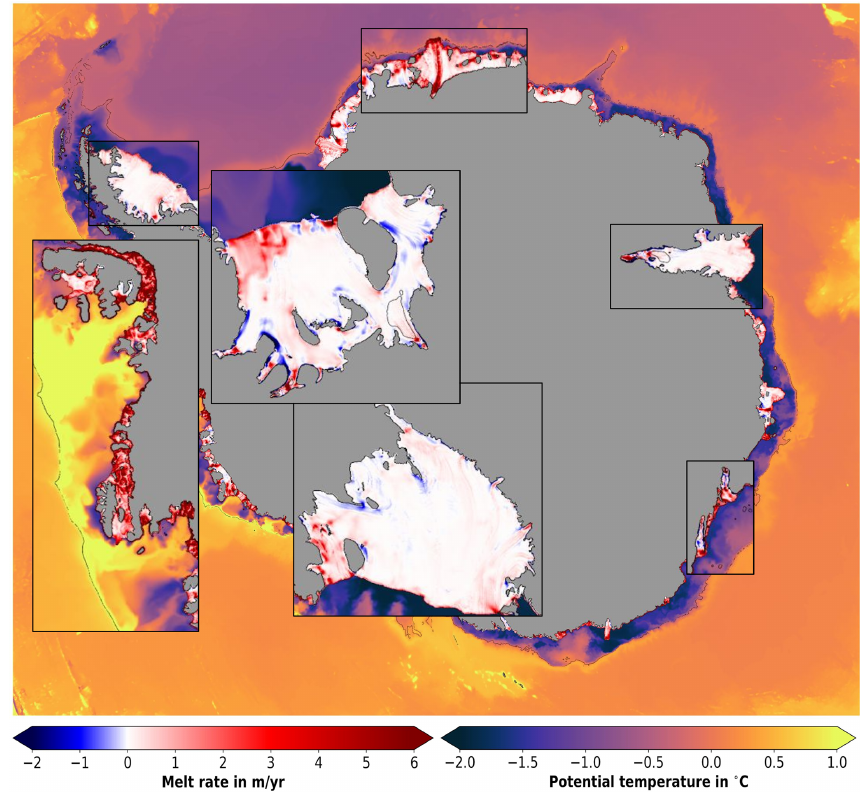
Figure 7. Ice shelf melting and bottom layer temperatures. Annual ice shelf basal melt rate is shown where ice shelves are present (negative is refreezing; note the shifted colour bar). Colours seaward of ice shelves show the annual average bottom sigma layer potential temperature. Thin black lines represent the 1500m